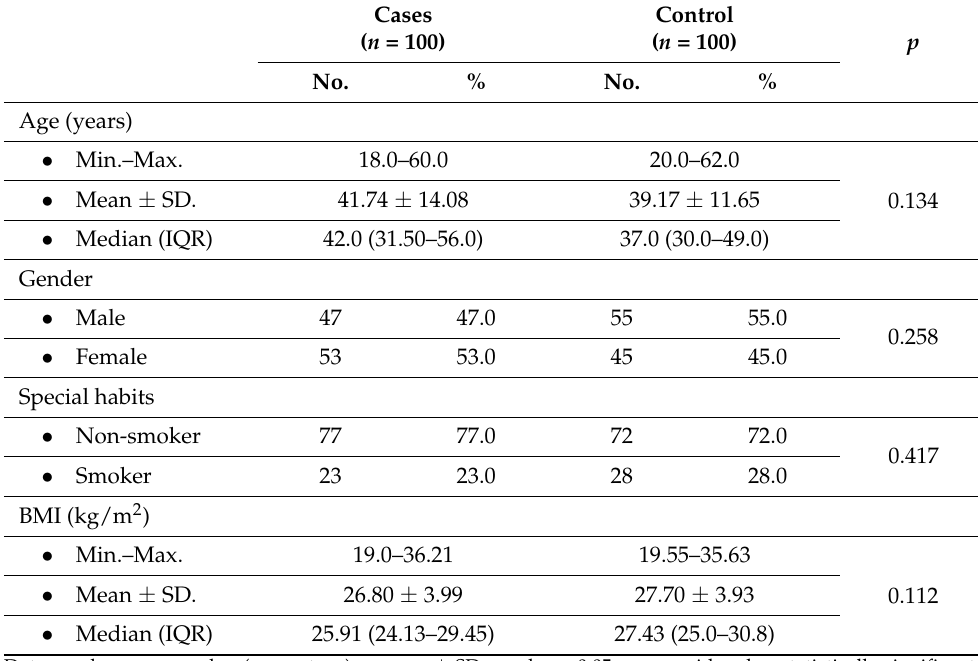
Table 1. Baseline characteristics among the study population.